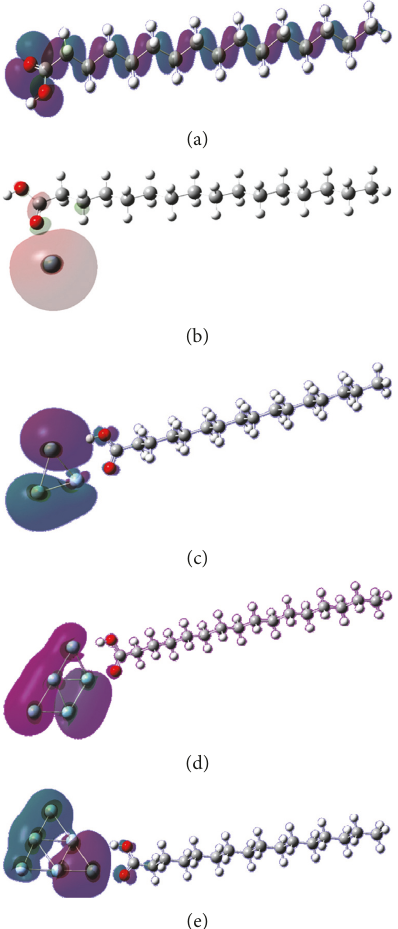
Figure 10: HOMO surfaces of (a) palmitic acid and the complex between palmitic acid with (b) a single silver atom, (c) cluster of 3 silver atoms, (d) cluster of 5 silver atoms, and (e) cluster of 6 silver atoms.